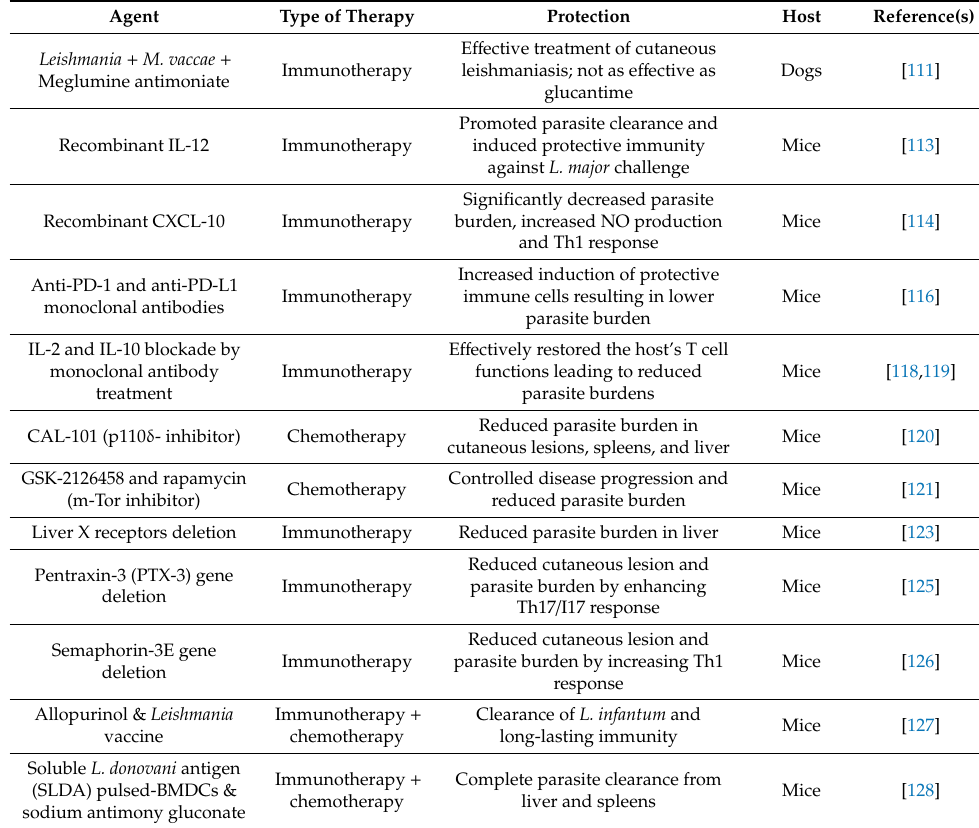
Table 2. Advances in immunotherapy against